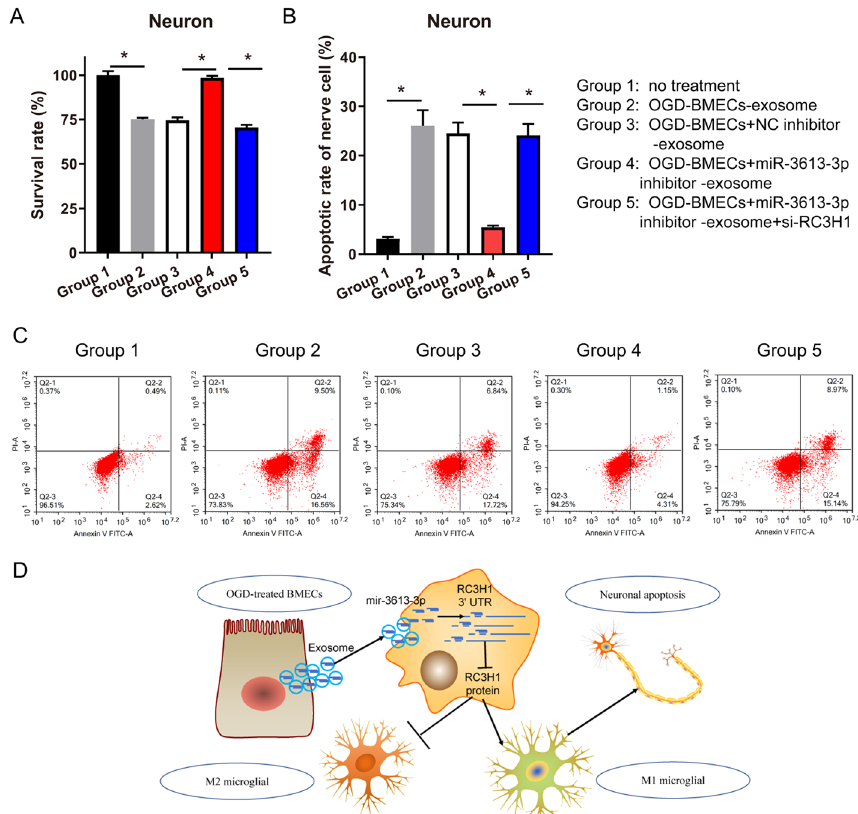
Fig. 4 Microglia M1 polarization regulated by BMEC exosomes reduces neuronal survival. A The proliferation of neurons was analyzed by MTS. The survival rate as a percentage of the OD value of the other groups and the OD value of the no-treatment group. B The apoptotic rate of neurons was shown. C After co-culture with microglia, neuron apoptosis was detected by flow cytometry using Annexin V-FITC/PI apoptosis detection kit. Apoptosis representative images are shown. D Diagram of mechanism. Differences were analyzed using ANOVA, followed by post-hoc Dunnett’s multiple comparisons test. * p <